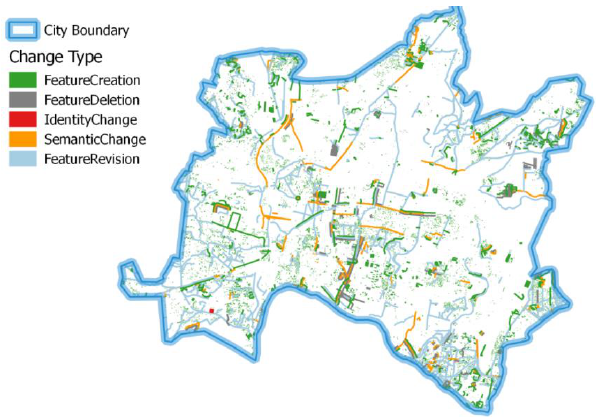
Figure 10. Change map of Berlin showing classified changes between January and June 2015.